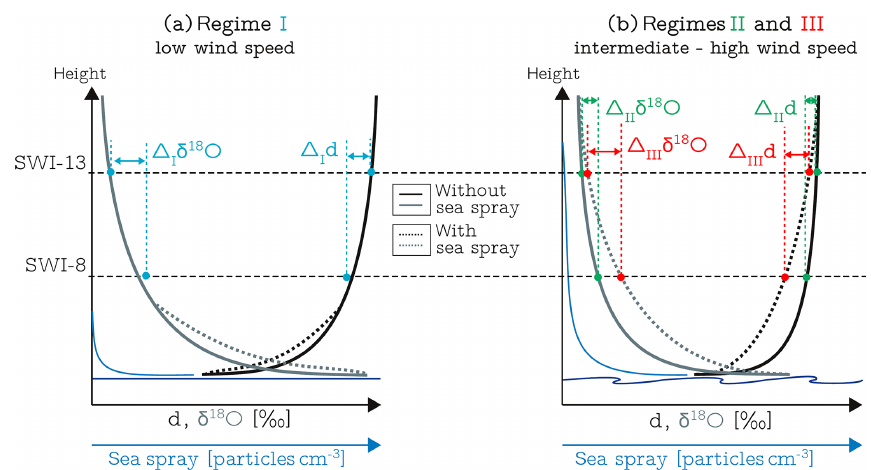
Figure 11. Schematic showing the vertical SWI gradient under low (a) and intermediate to high (b) wind speed conditions illustrating the three boundary layer turbulence regimes (I, II, III). (cid:49) I , (cid:49) II and (cid:49) III represent the vertical differences between SWI-13 and SWI-8 for the three regimes. For details, see